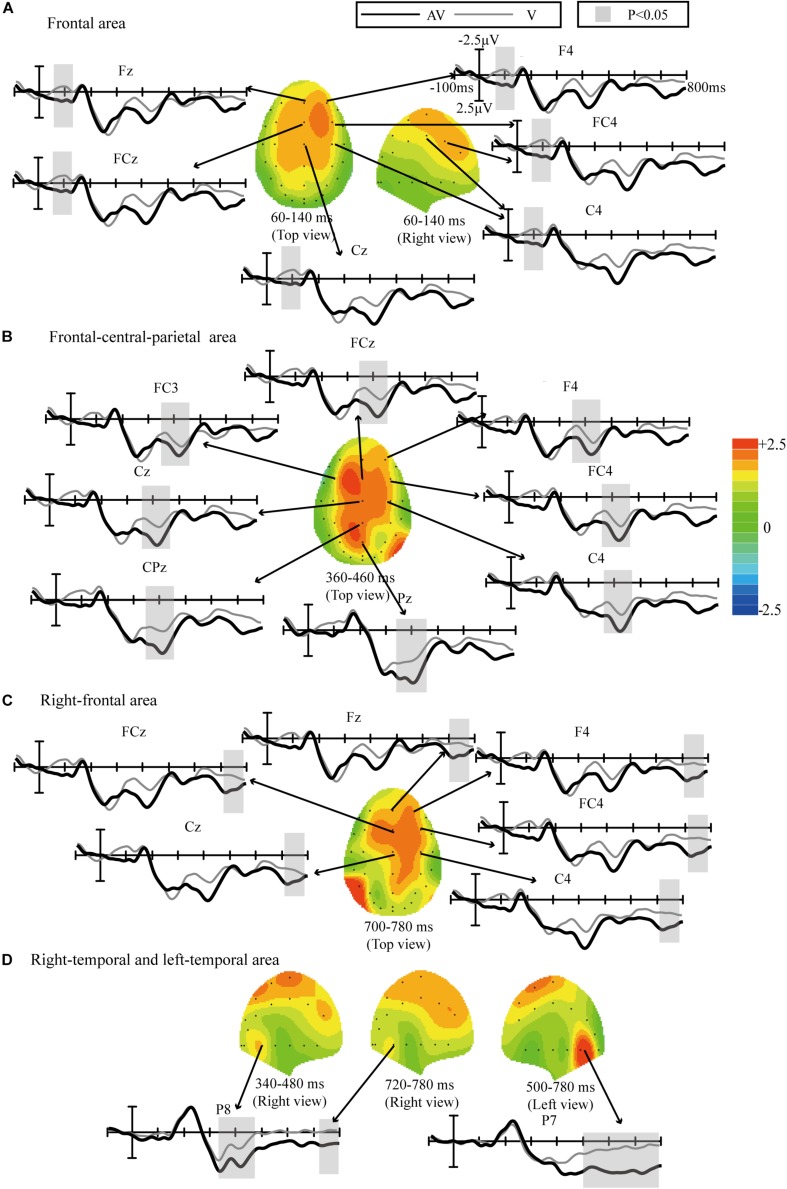
Comparison of waveforms elicited by the target stimuli in the V and AV spelling paradigms and scalp topographies from waveforms with difference formed by subtracting ERPs of the V spelling paradigm from those of the AV spelling paradigm: (A) the frontal area at 60–140 ms; (B) frontal–central–parietal at 360–460 ms; (C) right frontal at 700–780 ms; and (D) right temporal at 340–480 and 720–780 ms, and left temporal at 500–780 ms.